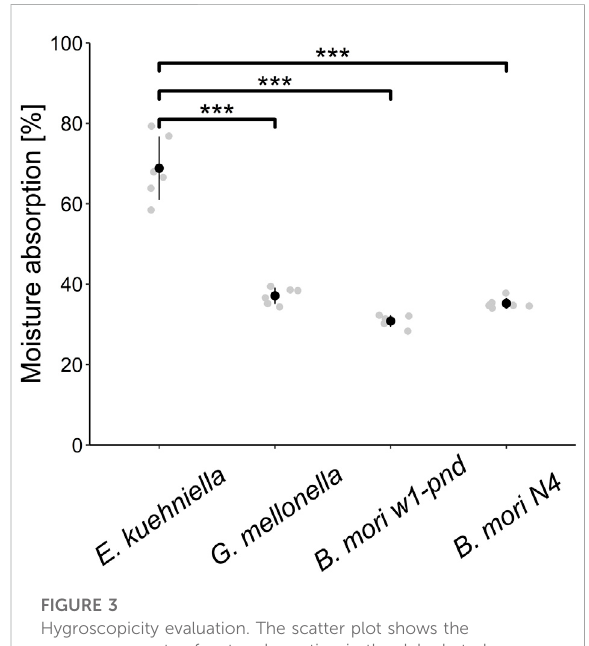
FIGURE 3 Hygroscopicity evaluation. The scatter plot shows the average amounts of water absorption in the dehydrated cocoon silk of E. kuehniella , G. mellonella , and B. mori w1-pnd and N4 strains. Black dots represent the mean, and vertical bars represent the mean ± SD. *** indicates p < 0.001 (paired t -test comparing means, n =